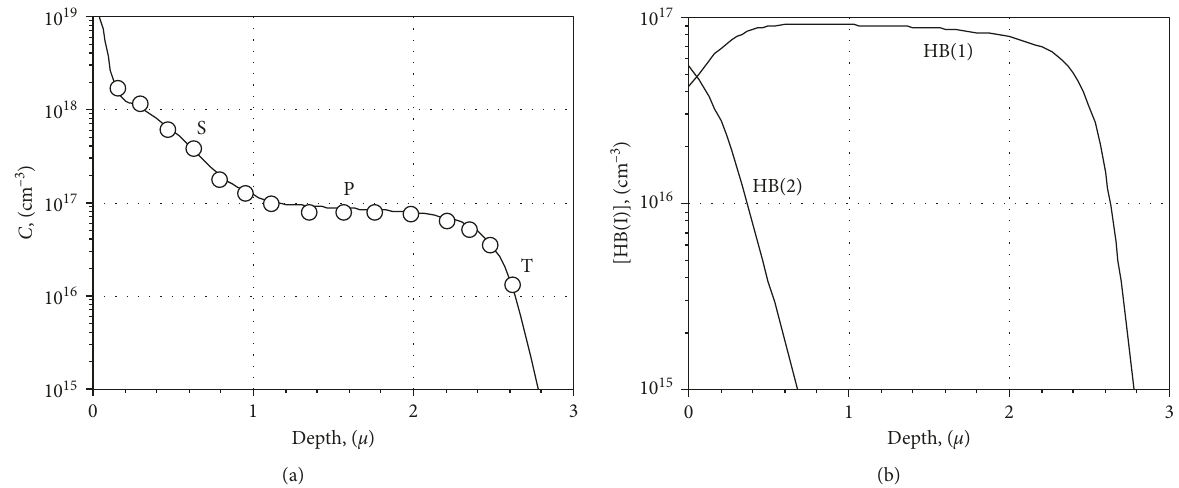
17 cm 3 annealed at 150 ° C for 2h [16]. (a) Total concentration due to boron B (cid:28) 10 −